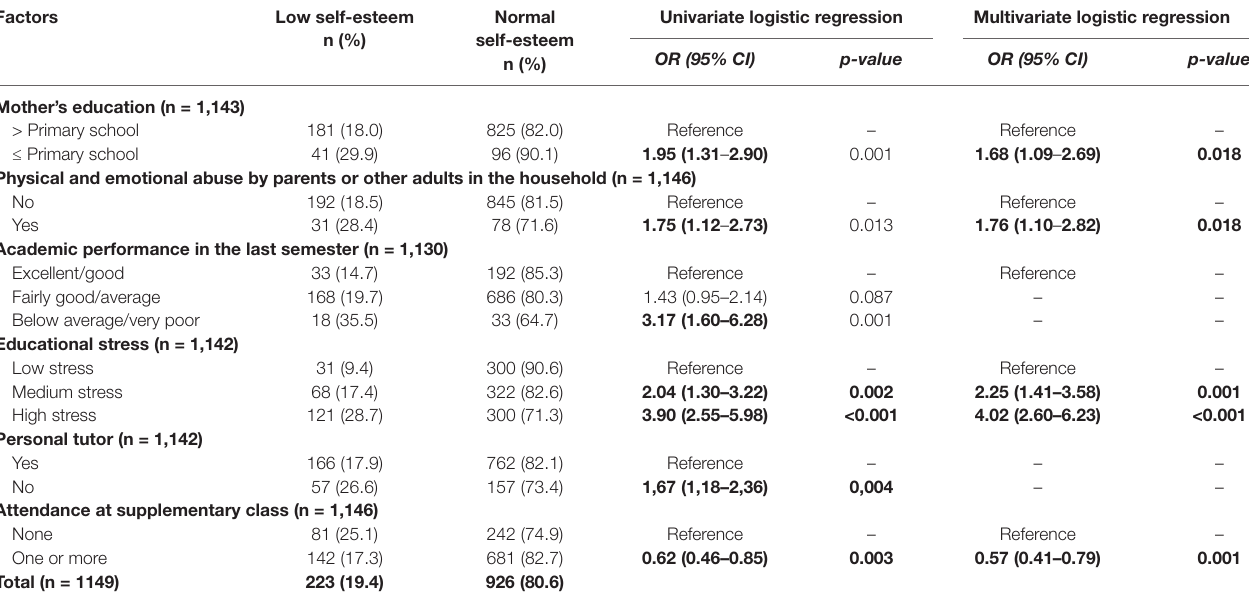
TABLE 2 | Factors associated with low self-esteem: multivariate logistic regression analyses. Factors